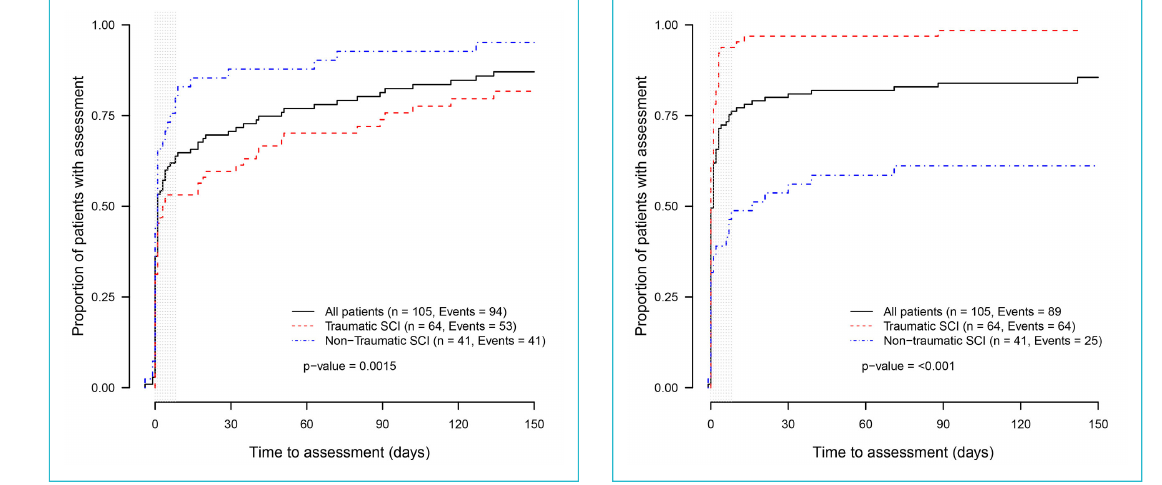
Figure 1: Magnetic resonance imaging after spinal cord injury (SCI) for patients with a traumatic versus a non-traumatic SCI.The grey shaded area represents the recommended time when the as- sessment should be performed. The black line represents all pa- tients, the coloured lines the respective subgroups.